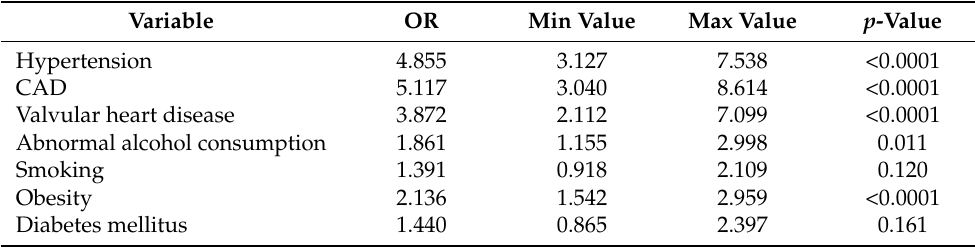
Table 5. Logistic regression analysis adjusted to age and gender.